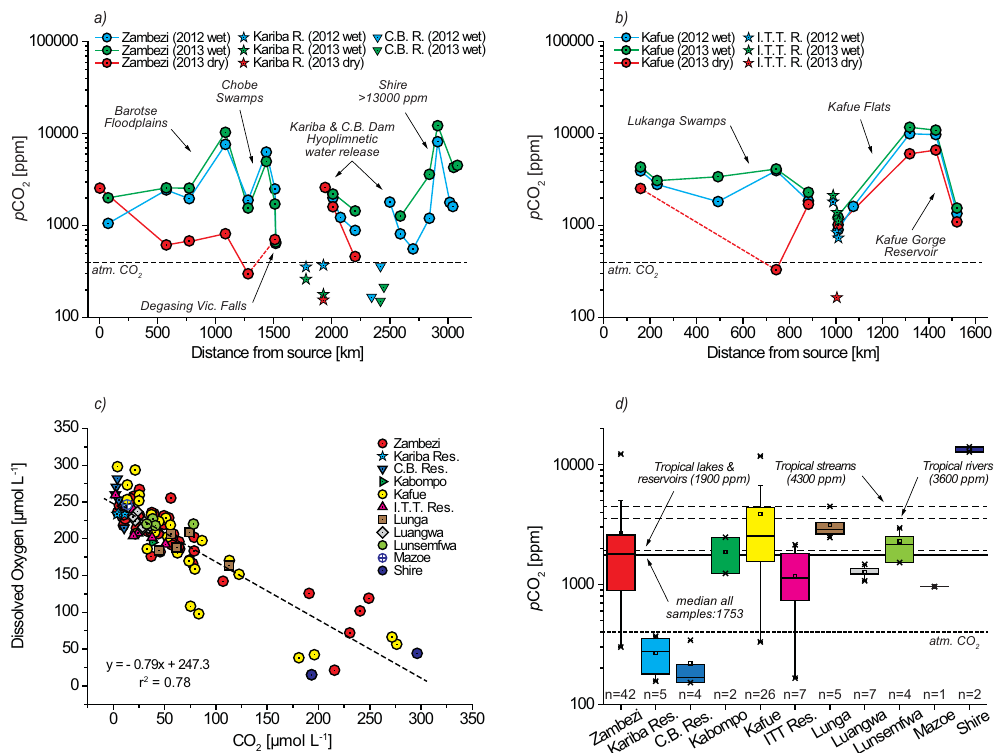
Figure 3. Spatial and temporal variability of p CO 2 along (a) the Zambezi River, including the Kariba Reservoir (Kariba R.) and Cahora Bassa Reservoir (C. B. R), and (b) the Kafue River, including the Itezhi Tezhi Reservoir (I. T. T. R.). Panel (c) shows the negative correlation between CO 2 and dissolved oxygen (µmolL − 1 ) . Panel (d) shows the overall range in p CO 2 for the Zambezi River, tributaries and reservoirs. Box plots show range, percentile, median, mean and outliers. The dotted line represents atmospheric CO 2 concentration, while dashed lines represent global median p CO 2 values for tropical rivers, streams and lakes/reservoirs based on Aufdenkampe et al. (2011). The solid line represents the median p CO 2 value (1753ppm) of all sites during the entire sampling